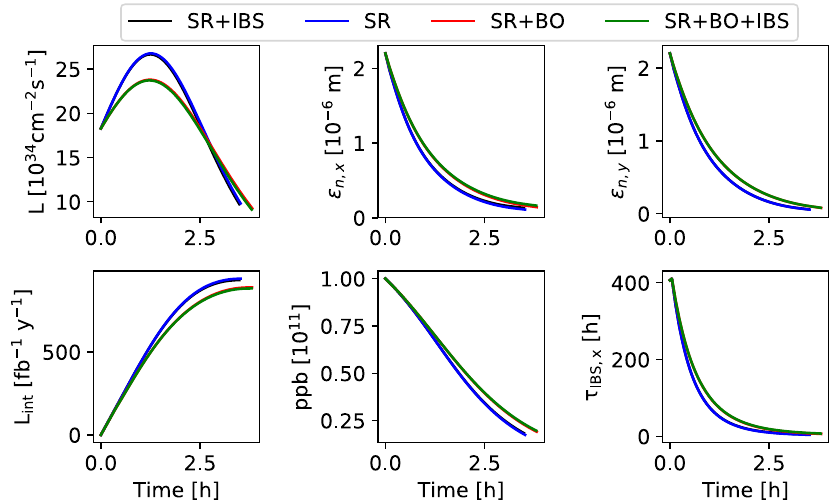
FIG. 9. Simulated physics for FCC-hh, including synchrotron radiation (SR), intrabeam scattering (IBS) or emittance growth due to burn-off